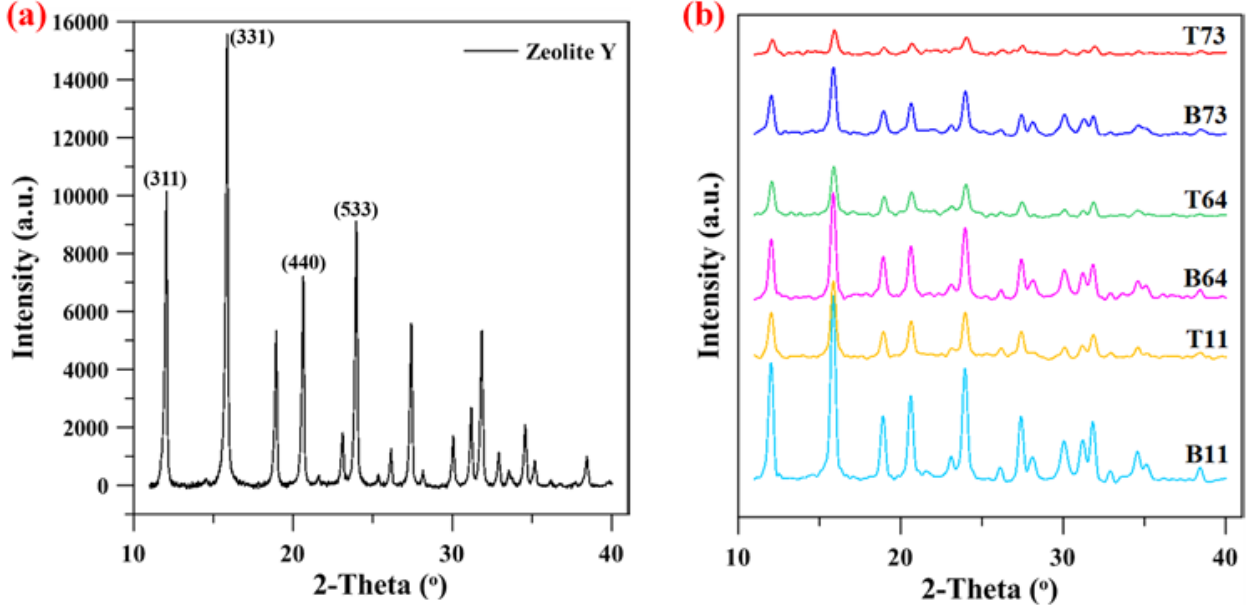
Figure 7. XRD graph of ( a ) Pristine/commercial zeolite Y and ( b ) Ball-milled samples. Table 2. Summary of crystallinity index, D50 results, and cumulative frequency of particles with diameter <100 nm for commercial zeolite Y and all ball-milled